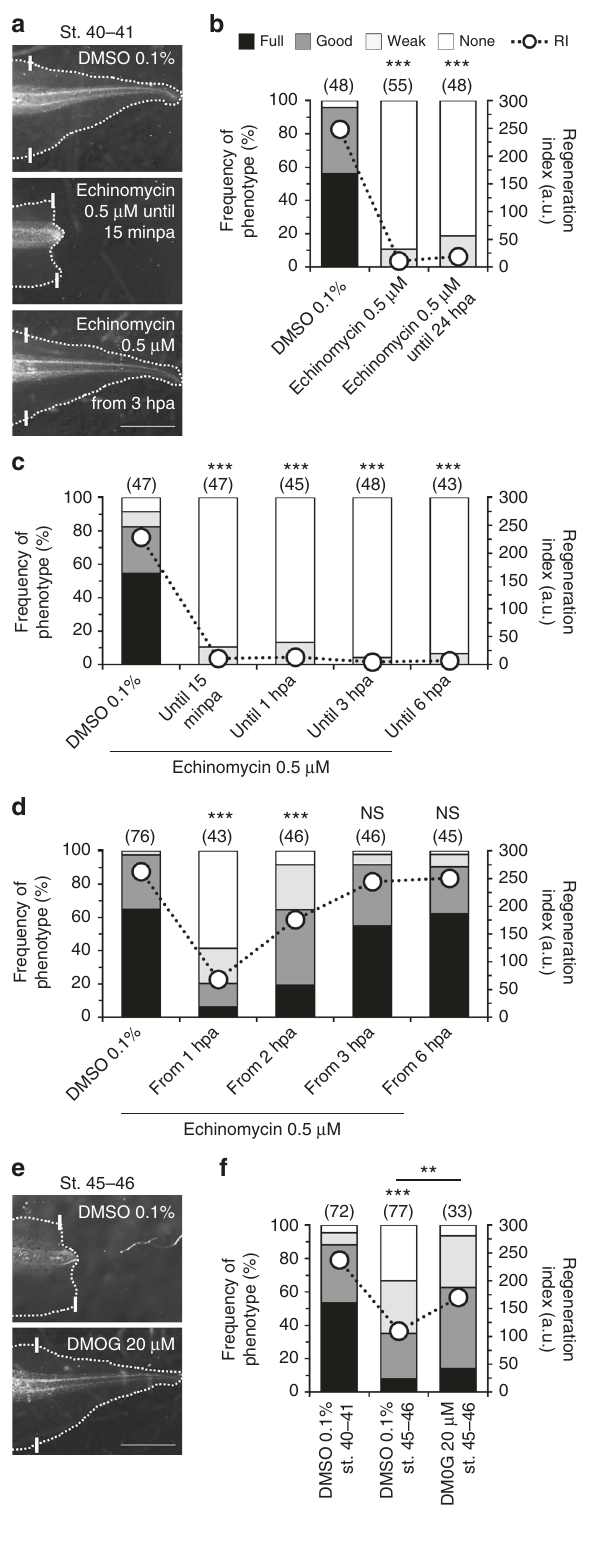
Fig. 4 HIF-1 α is necessary for and suf fi cient to induce regeneration. a – d Loss of regeneration by HIF-1 α inhibition and temporal requirement for HIF-1 α activity during regeneration. a Representative tails at 7 dpa in vehicle-control and pharmacological treatment from tadpoles amputated at st. 40 – 41. b – d Qualitative and quantitative analyses of regeneration ef fi ciency for the different conditions tested. RI regeneration index. Stacked bars legend in b applies to c , d , and f . e , f Induction of regeneration by HIF- 1 α stabilization. e Representative tails at 7 dpa in vehicle-control and pharmacological treatment from tadpoles amputated in refractory period. f Qualitative and quantitative analyses of regeneration ef fi ciency for the different conditions tested. White solid lines: amputation plane; scale bar: 1 mm; a.u. arbitrary units. Statistical analyses were performed by Fisher ’ s exact test (two-tailed p -value). n biological replicates indicated in